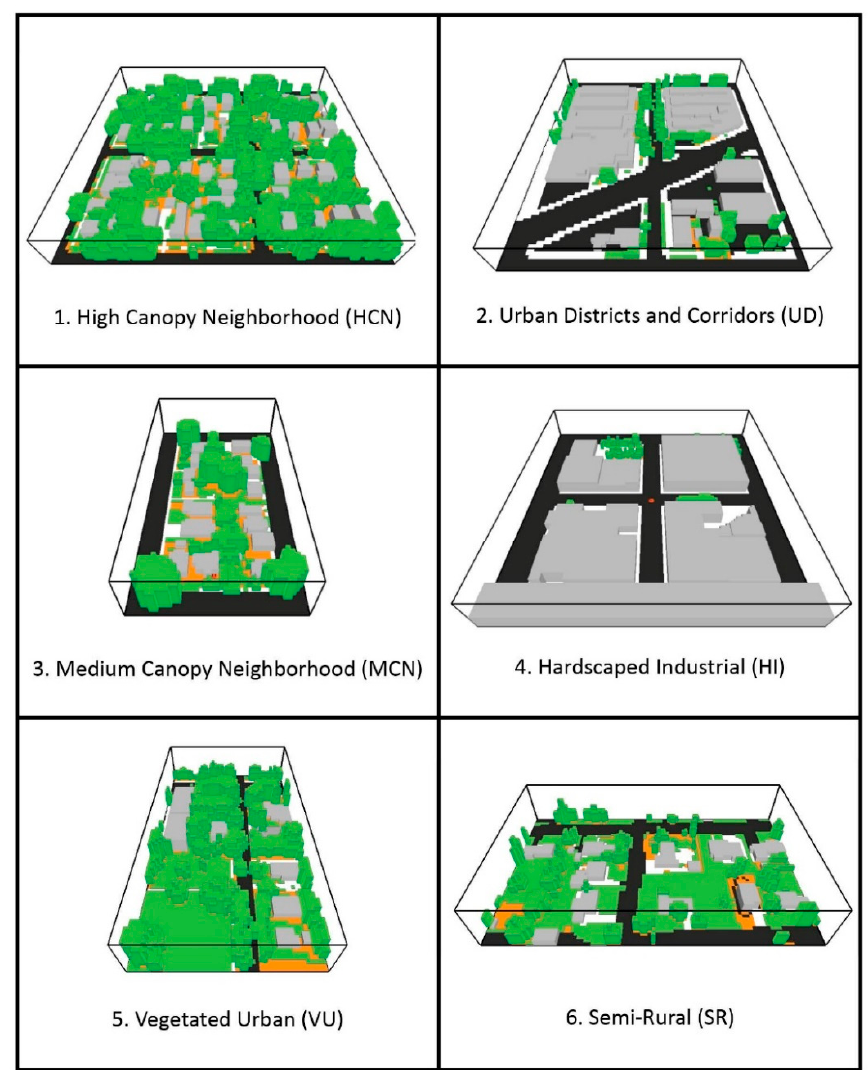
Figure 1. Input files for ENVI-met, representing the dominant land-use and/or land-cover types for each of the six selected study sites. Table 2. Color key for ENVI-met input files shown in Figure 1.